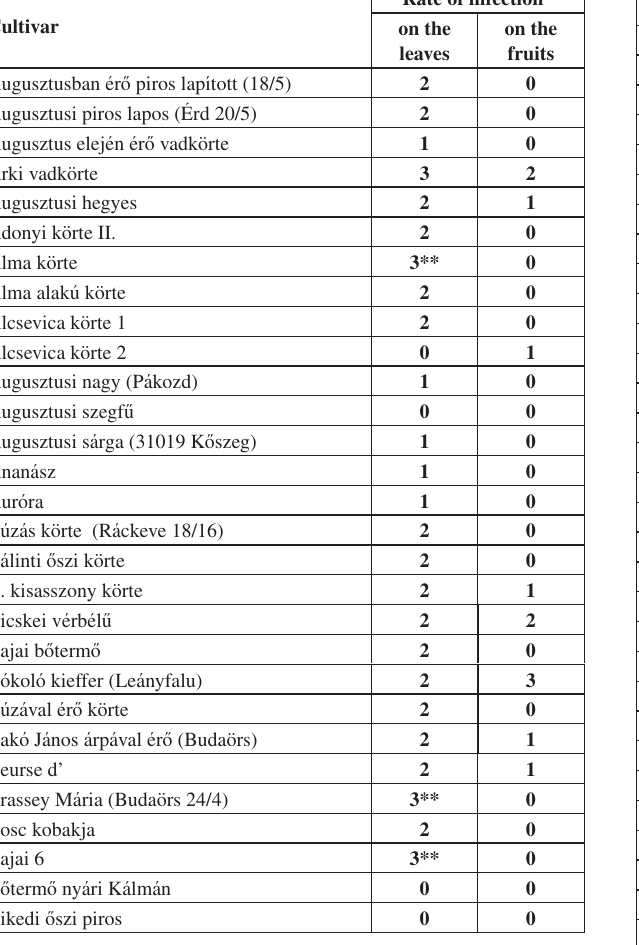
Table 1. Average Venturia pirina fi eld infection of European pear genotypes at the ’Újfehértó’ pear gene bank (Hungary), in the four years with favourable weather to disease incidence (1998, 2004, 2006, 2008), during the nine years period between 1996–1999 and 2004–2008. Cultivar